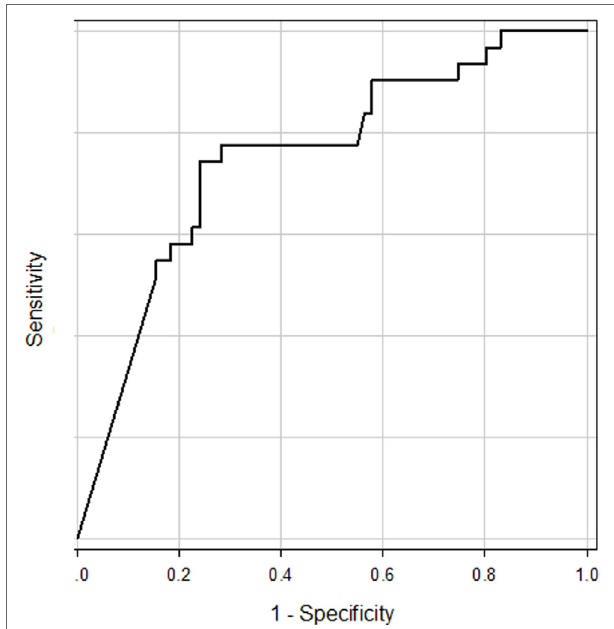
FigUre 2 | representative cervical vestibular-evoked myogenic potential (cVeMP) responses tuning property test positive . This patient was a 22-year-old woman with right Ménière’s disease. In this case, 500–1,000 Hz cVEMP slopes were − 29.8 in the right and 0 in the